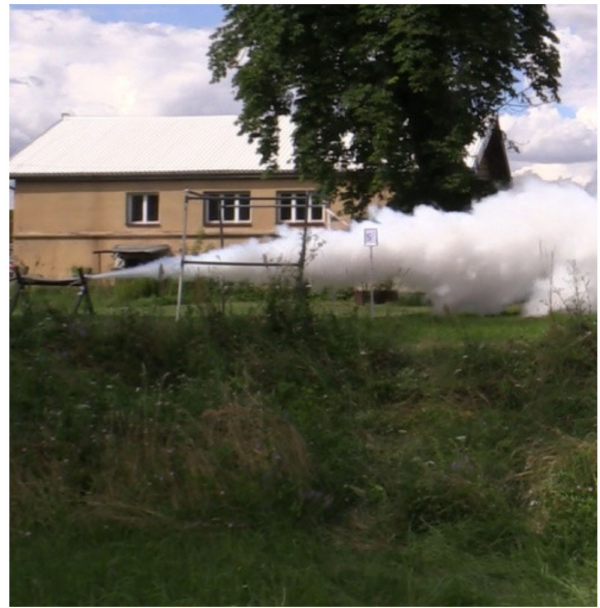
Figure 2. Release of LNG and its phase transition due to turbulent flow from the hose (Q = 1.67 kgs − 1 , u w = 0.89 ms − 1 , p out = 6 atm, d = 40 mm).